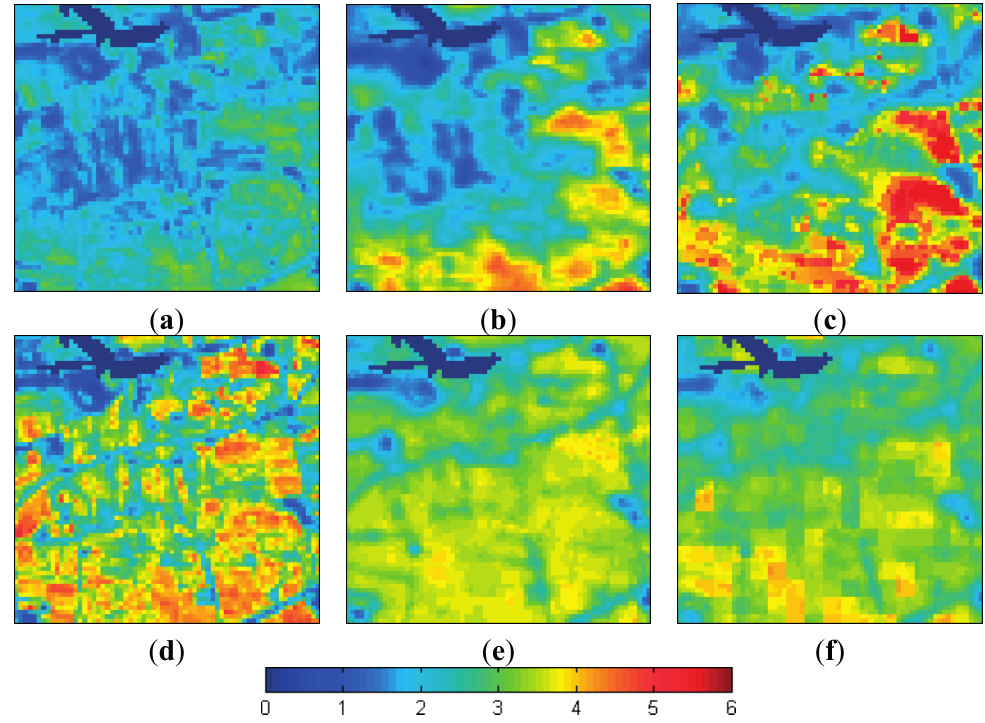
Figure 10. The generated multi-temporal LAI reference maps at 30-m resolution on ( a ) DOY 185; ( b ) DOY 193; ( c ) DOY 201; ( d ) DOY 209; ( e ) DOY 225 and ( f ) DOY